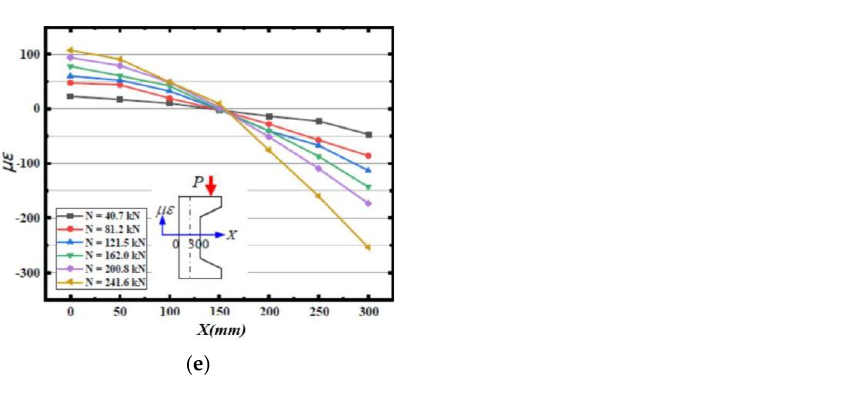
Figure 8. Strain distribution test results of each specimen section. ( a ) Tensioned side channel reinforcement method; ( b ) Tensile side corrugated steel plate reinforcement method; ( c ) Steel channel reinforcement on pressurized side; ( d ) Corrugated steel plate reinforcement on the pressurized side; ( e ) Unreinforced plain concrete.